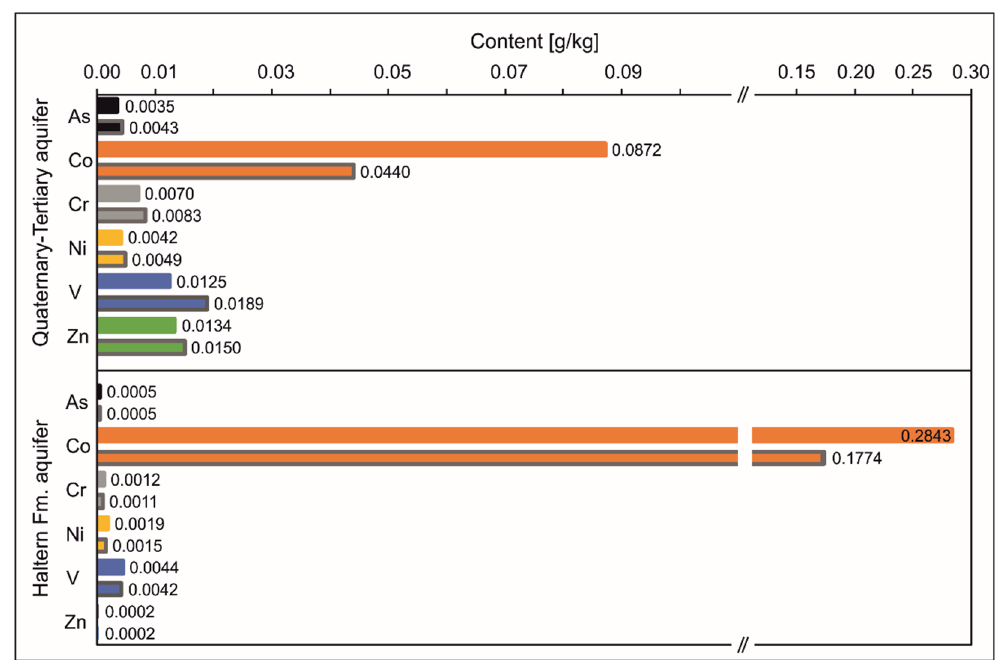
Figure 12. Content of elutable trace elements by redox inversion with ammonium oxalate. Before addition of C org : without gray frame. After addition of C org : with gray frame. Top: Quaternary–Tertiary aquifer. Bottom: Haltern Fm. aquifer. Note the change of scale on the x -axis.